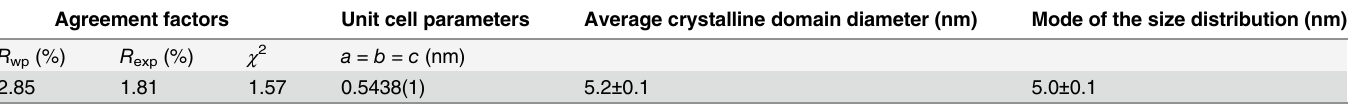
Table 1. WPPM agreement factors, unit cell parameters and average crystalline domain diameter of CeO 2 .